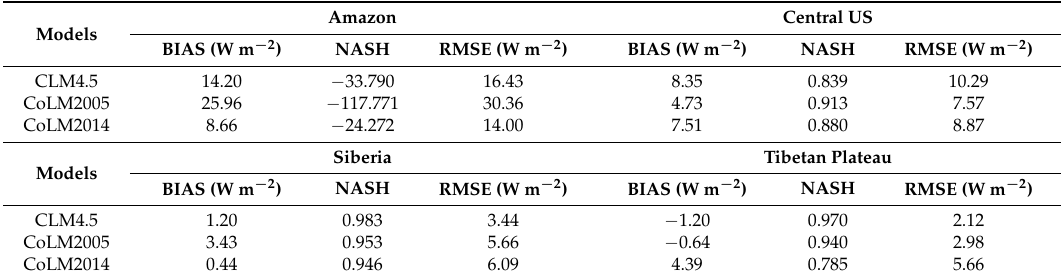
Table 5. Statistical summary of simulated latent heat flux annual